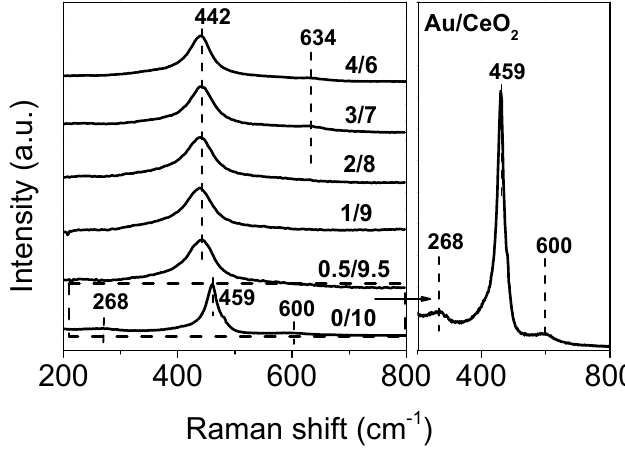
Figure 3. Raman spectra of the Au/Ce 1 − x Mn x O 2 − δ catalysts with different Mn/Ce ratios.